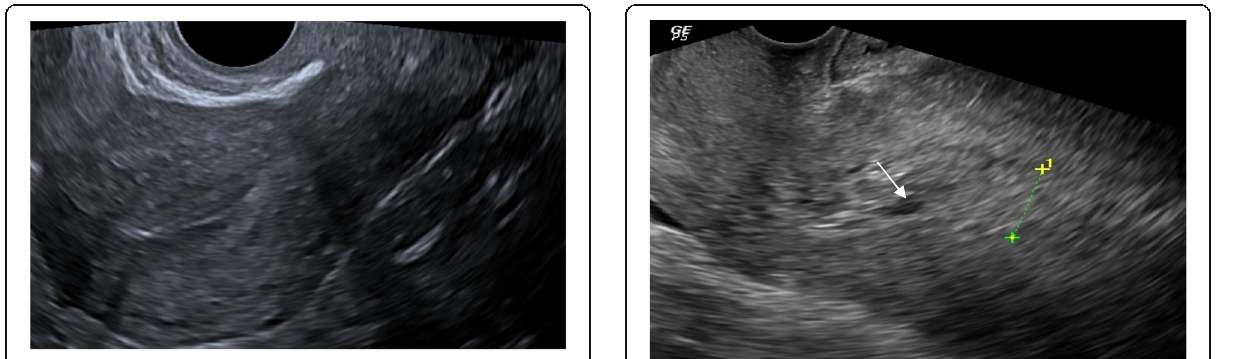
Fig. 4 Sagittal view by TVUS showing thickened echogenic endometrium, measuring about 11.5 mm in maximal anteroposterior diameter with regular endometrial outline and heterogenous echo pattern with multiple echogenic areas seen scattered through myometrium (enlarged glands). Histopatholgy result of the endometrial biopsy was consistent with adenomyosis